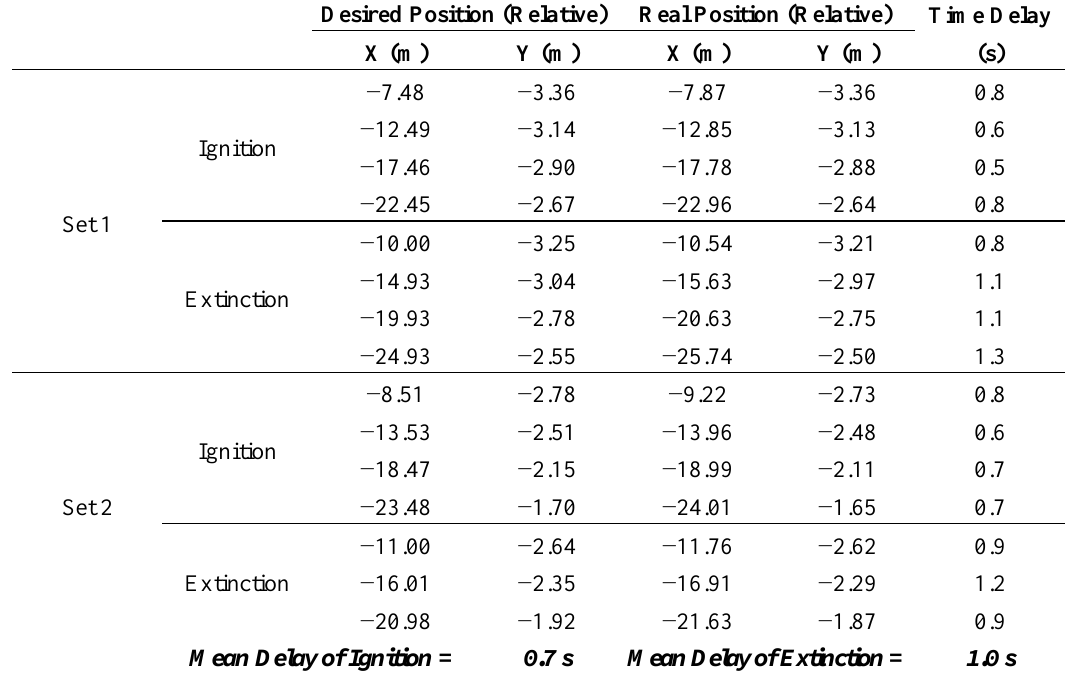
associated relative UTM positions where the action was detected, and the produced delays.